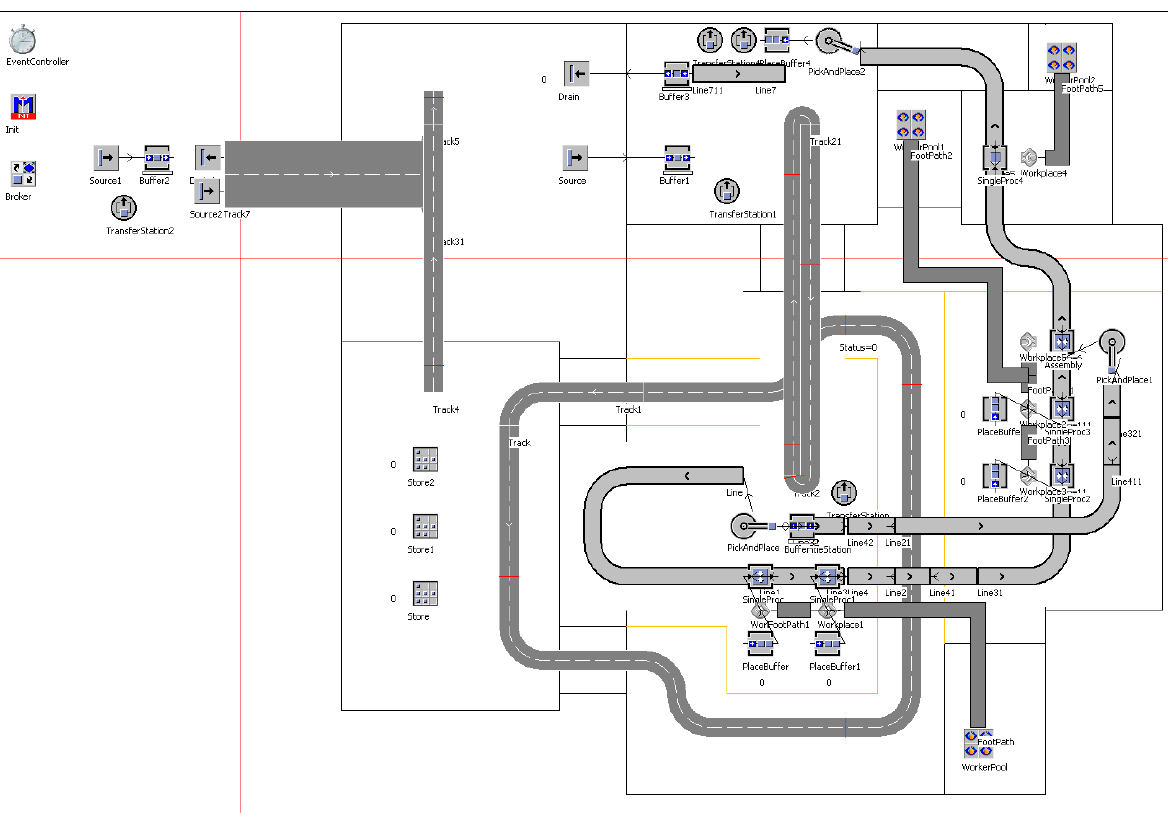
Figure 3: Example of a simulation model to analyze the operation of the